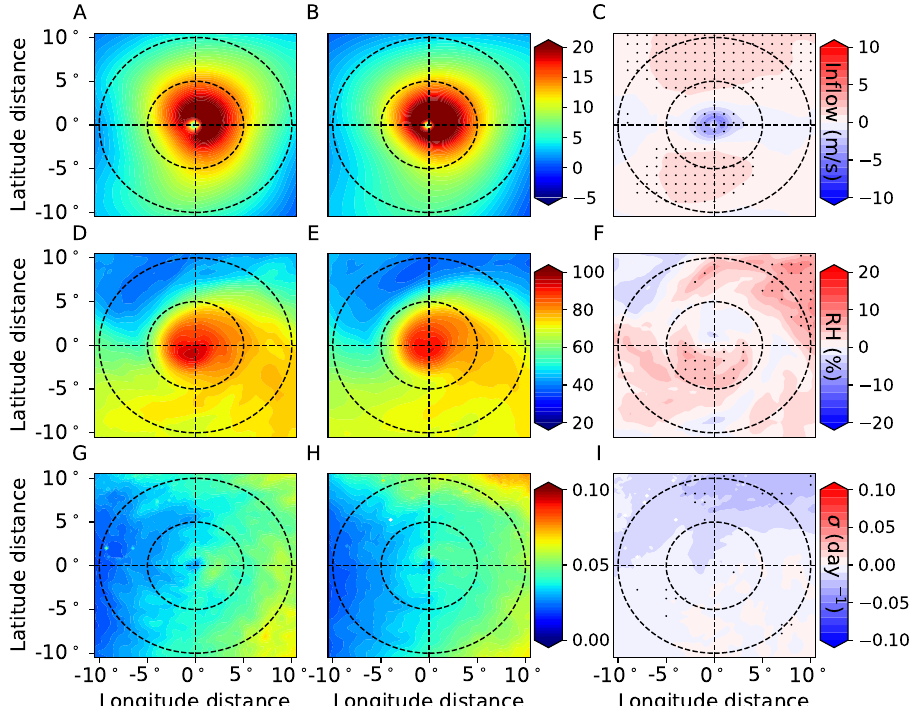
Figure 9. The atmospheric conditions within a 21 ◦ × 21 ◦ box with the TC centered. ( A ) and ( B ) depict the composite 850 hPa radial inflow (units: m/s) for the RG and non-RG events, and ( C ) shows the difference between (A) and (B). ( D – F ) are the same with ( A – C ), but for the 600 hPa relative humidity (RH, units: %). ( G – I ) are the same as ( A – C ), but for the 700 hPa Eady growth rate ( σ , units: day − 1 ). The factors are composited using data from the ERA5 reanalysis. Stippled areas in the right panel indicate that the differences are statistically significant at the 99% confidence level based on Student’s t-test. The two circles are placed at radii of 5 and 10 degrees from the TC center. The composite maps, as shown in Figure 9, of low-level radial inflow, mid-level relative humidity, and mid-level baroclinic instability during the TC passage show the difference in atmospheric conditions between RG and non-RG events. Similar to